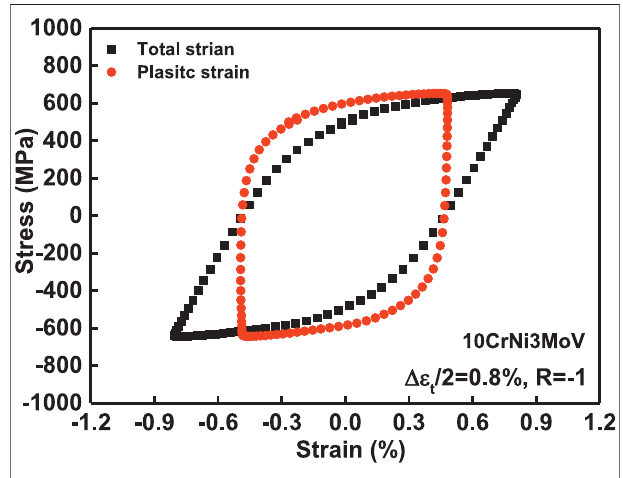
Frontiers in Materials |